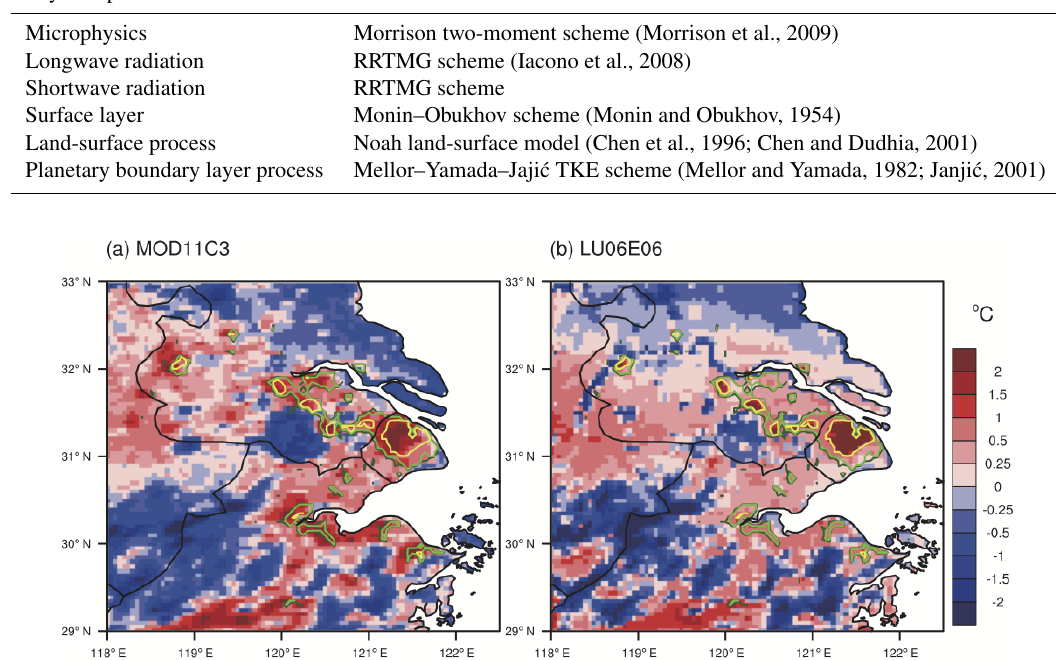
Figure 2. Moving spatial anomalies of averaged surface skin temperature (units: ◦ C) with a filtering window size of 1 ◦ × 1 ◦ for (a) MODIS observation and (b) the L06E06 simulation. The high-intensity residential and commercial/industrial/transportation areas are marked with green lines and yellow lines,